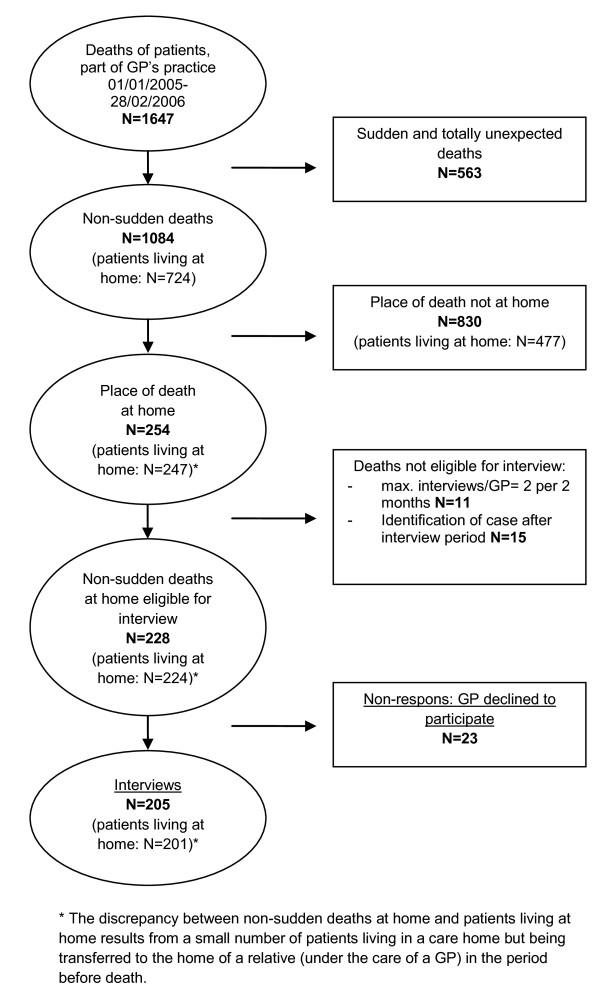
Study population.